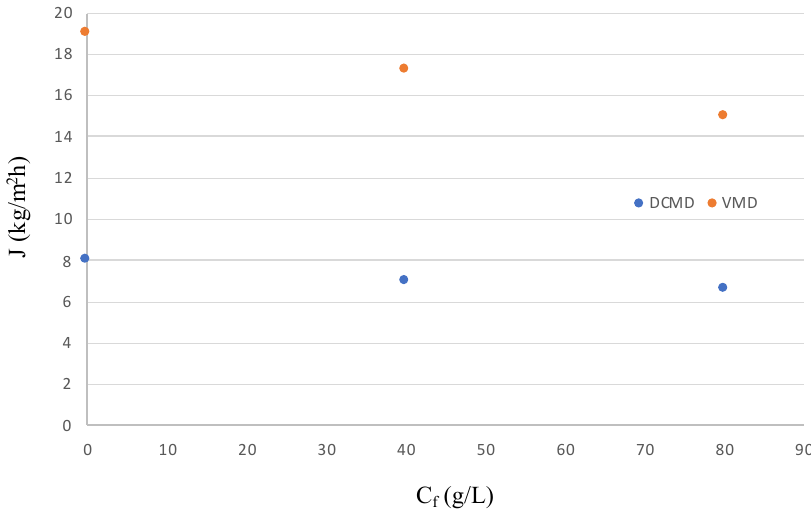
Figure 13. Comparison of DCMD and VMD at 40 °C.